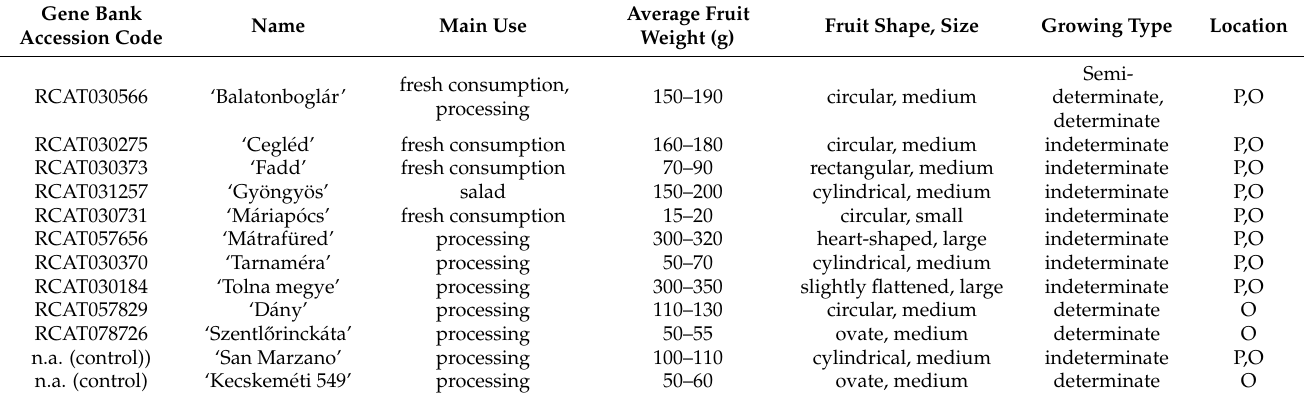
Table 2. Tomato landraces and commercial (control) varieties used in the